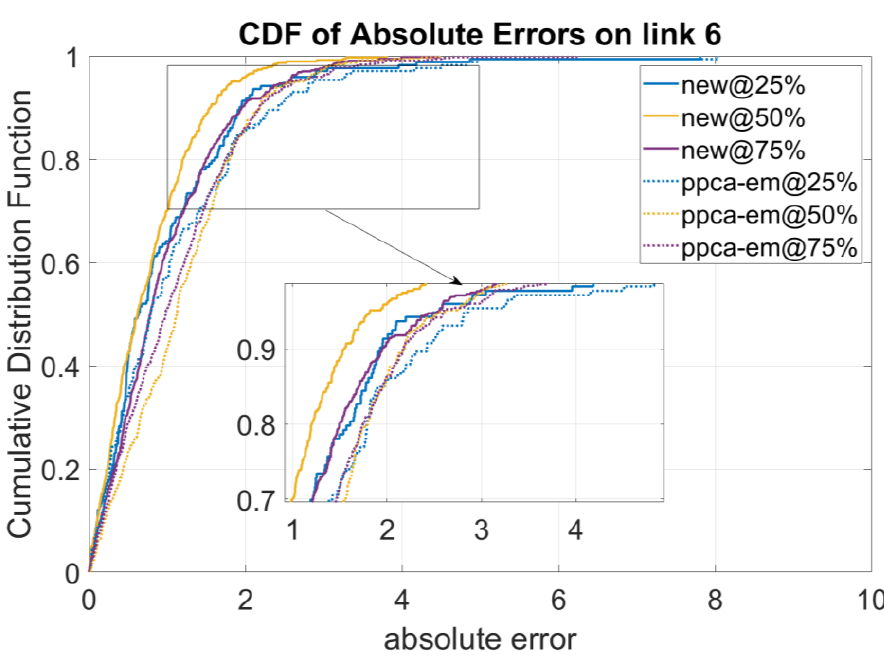
Figure 5. Performance of Models on the Link with Lowest p-Score Values.